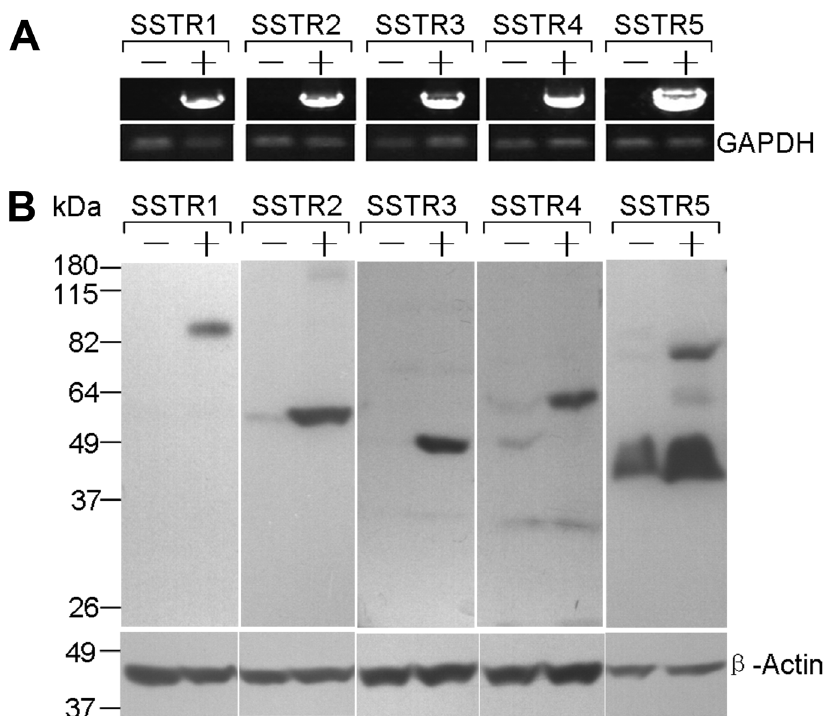
Figure 1. Identification of HEK 293 cells stably expressing human SSTR1-5. (A) RT-PCR analysis showing mRNA expression of SSTR1-5 in either HEK 293 cells or HEK 293 cells transfected with SSTR1-5 respectively. 1.5 m g of DNA-free RNA was reverse transcribed and co-amplified with primers specific for SSTR1-5 and GAPDH. 5 m L of PCR products and fractionated on agarose gels then visualized under UV lighting. (B) Western blot analysis showing protein expression of SSTR1-5 in either HEK 293 cells or HEK 293 cells transfected with SSTR1-5 respectively. 25 m g of protein was fractionated by SDS-PAGE and probed with appropriate SSTR antibodies.